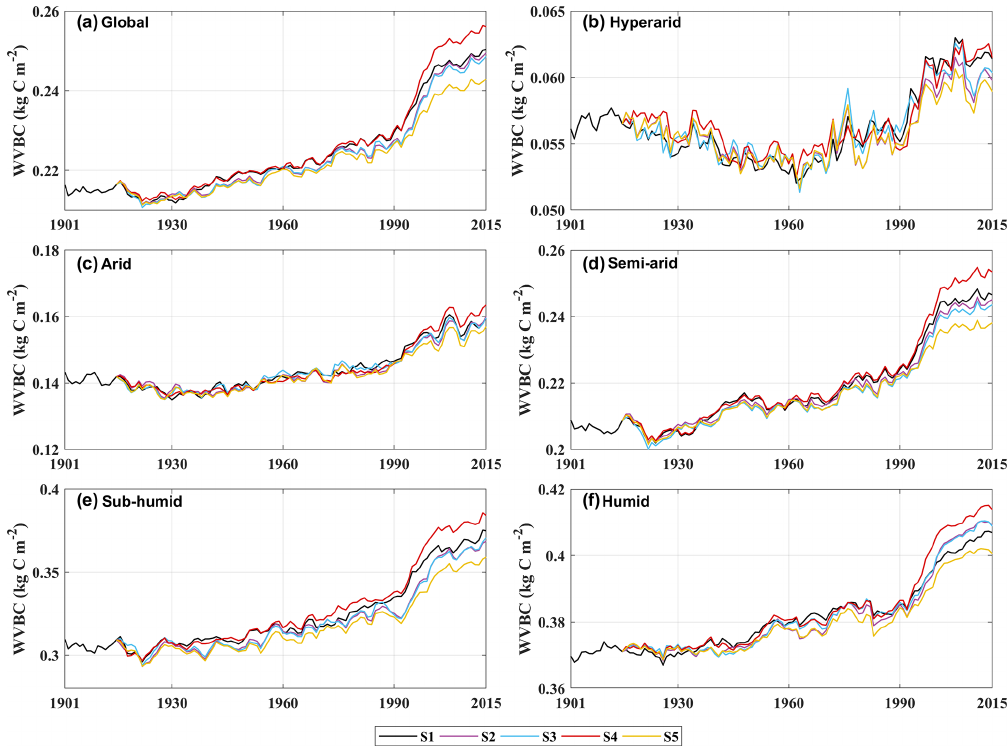
Figure A8. Trends in average density of potential WVBC. (a) Modelled trend of annually averaged WVBC globally. Modelled trends in annually averaged WVBC in hyper-arid regions (b) , arid regions (c) , semi-arid regions (d) , sub-humid regions (e) , and humid regions (f)